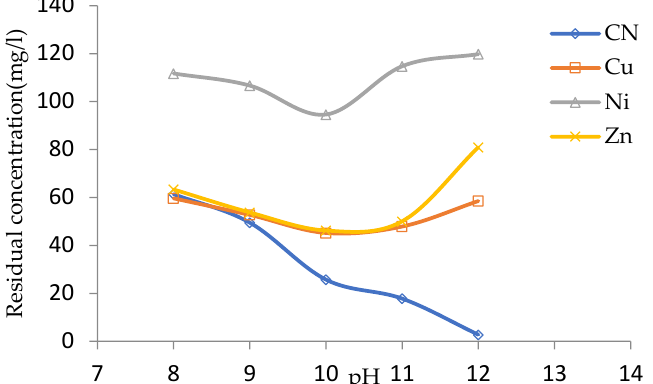
Figure 2. Removal of cyanide and heavy metal by (Hp) at different pHs.